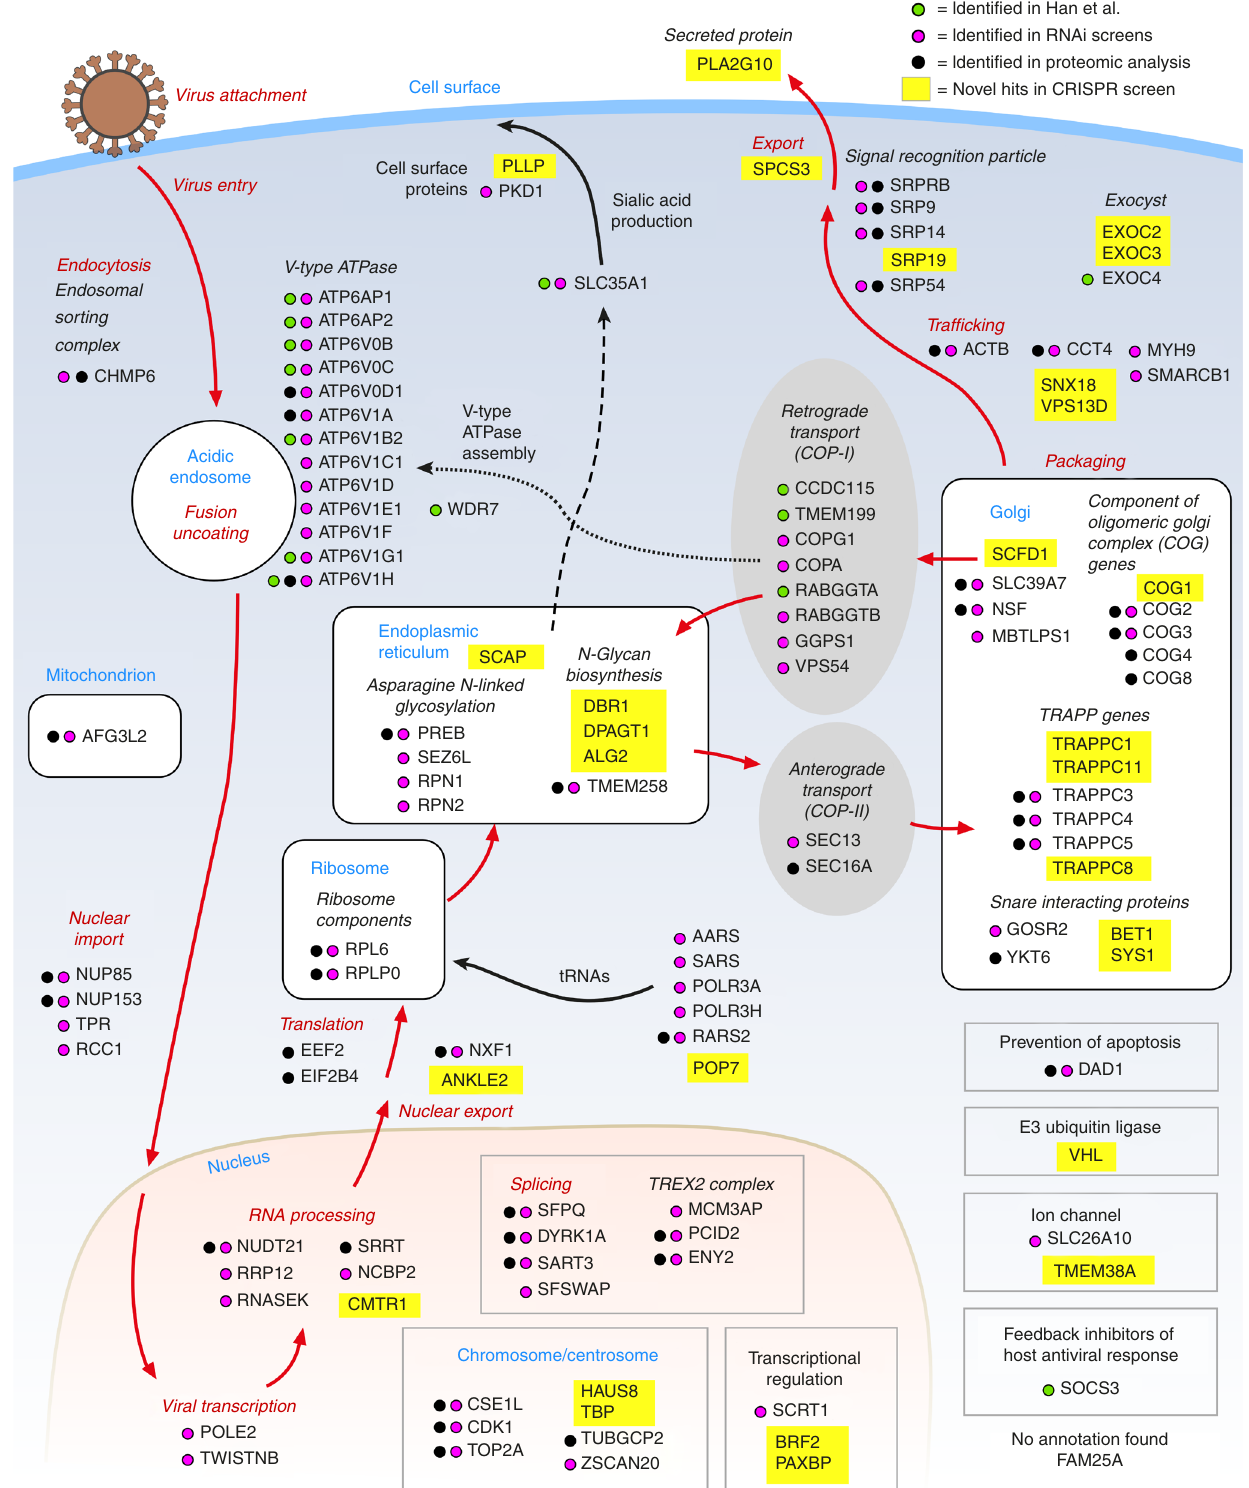
Fig. 2 CRISPR screens hits and their predicted roles in the IAV life cycle. Diagram showing all 121 hits from our CRISPR screen (FDR < 0.05) and their predicted roles in the IAV life cycle. Hits are marked by a colored dot if they had also been identi fi ed in previous RNAi screens (Magenta), proteomic studies (Black) or CRISPR screen (Green). Hits unique to our CRISPR screen are highlighted in